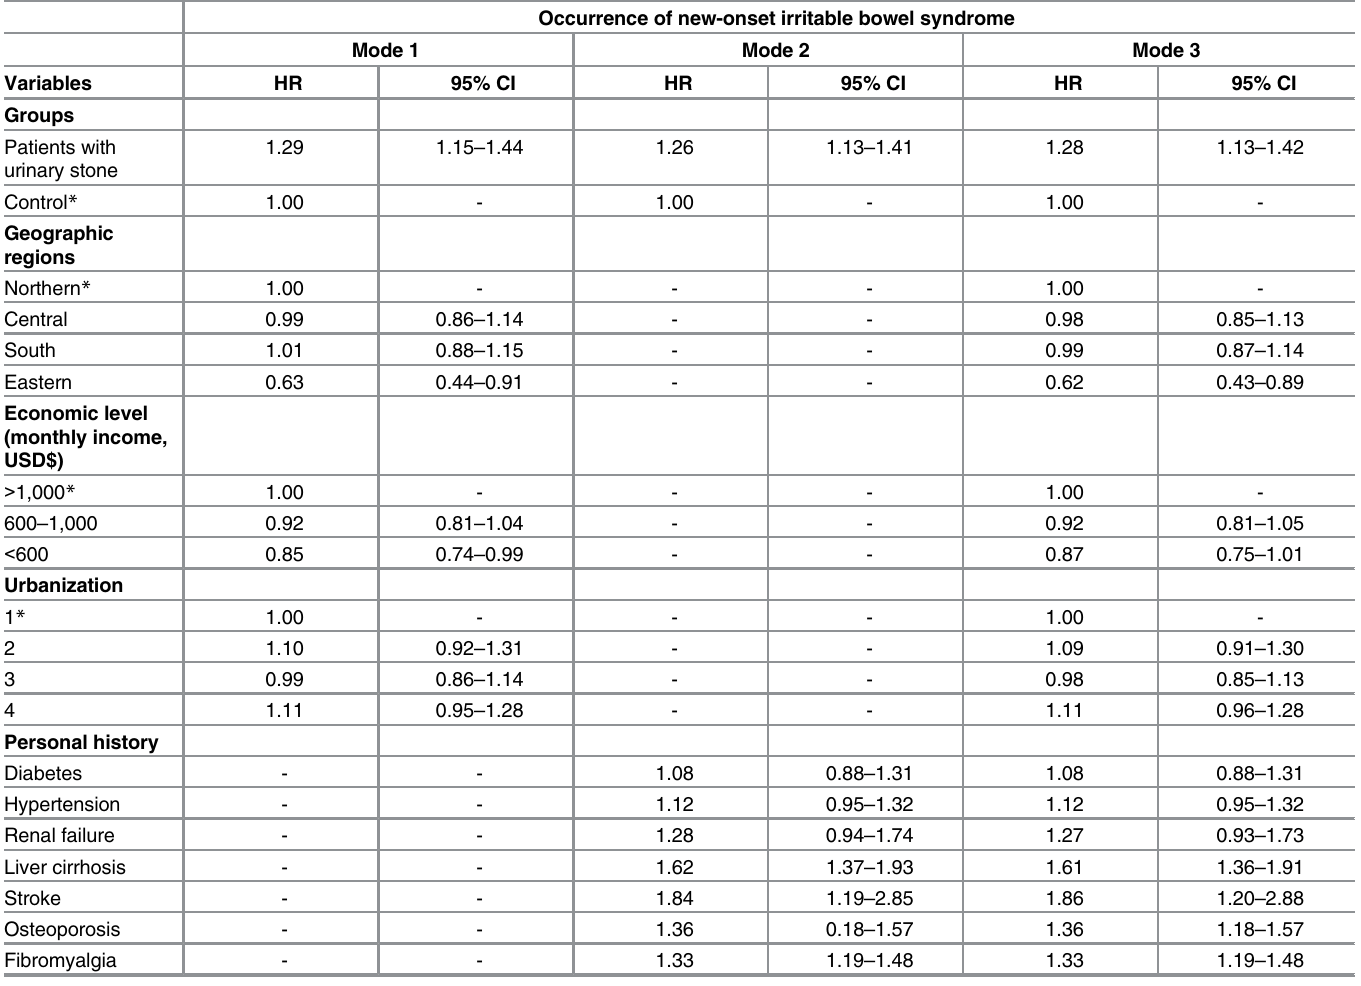
Table 3. Adjusted-effect estimates for urinary stone